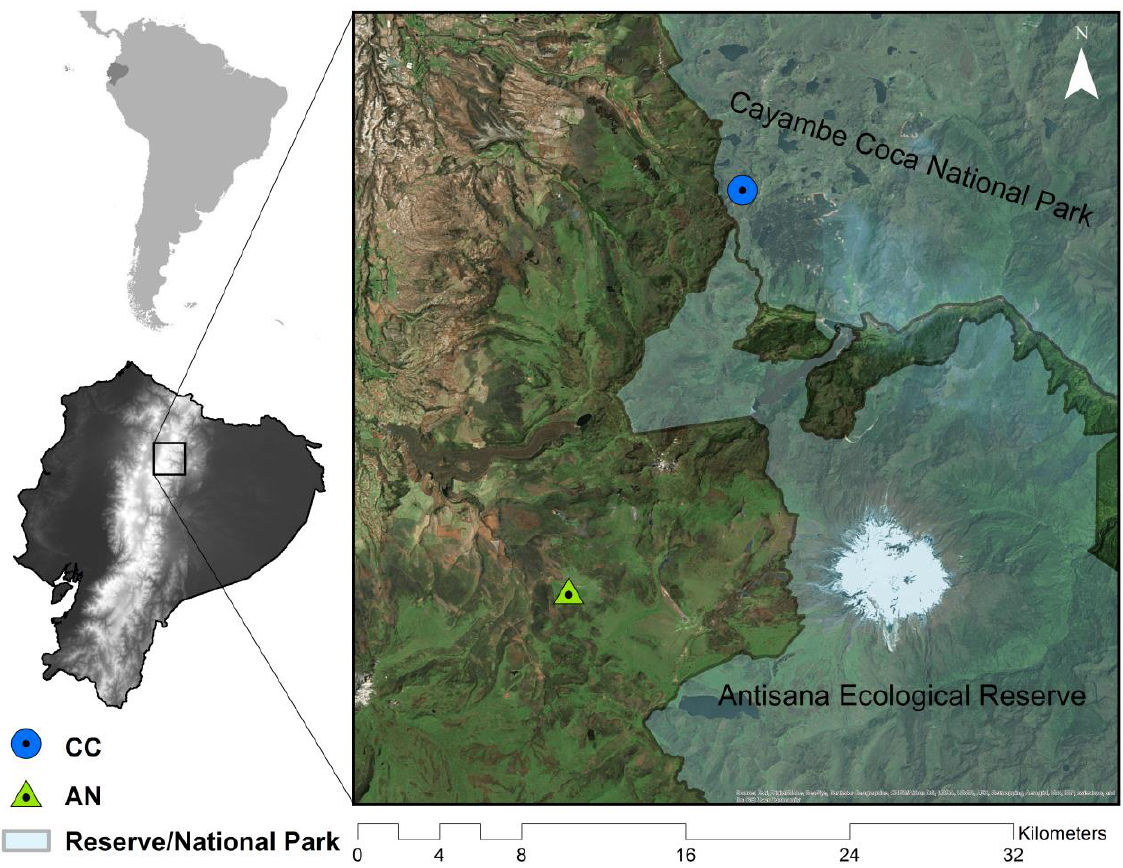
Figure 1. Map of sites in Cayambe Coca National Park (CC) and Antisana Ecological Reserve (AN) located in the Andean mountain region to the east of Quito, Ecuador. Satellite image includes intellectual property of ESRI and its licensors and are used herein under licence. Copyright © [World Imagery, August 2016] ESRI and its licensors. All rights reserved. Ecuador and South America maps: Diva-GIS, GADM Database of Global Administrative Areas, November